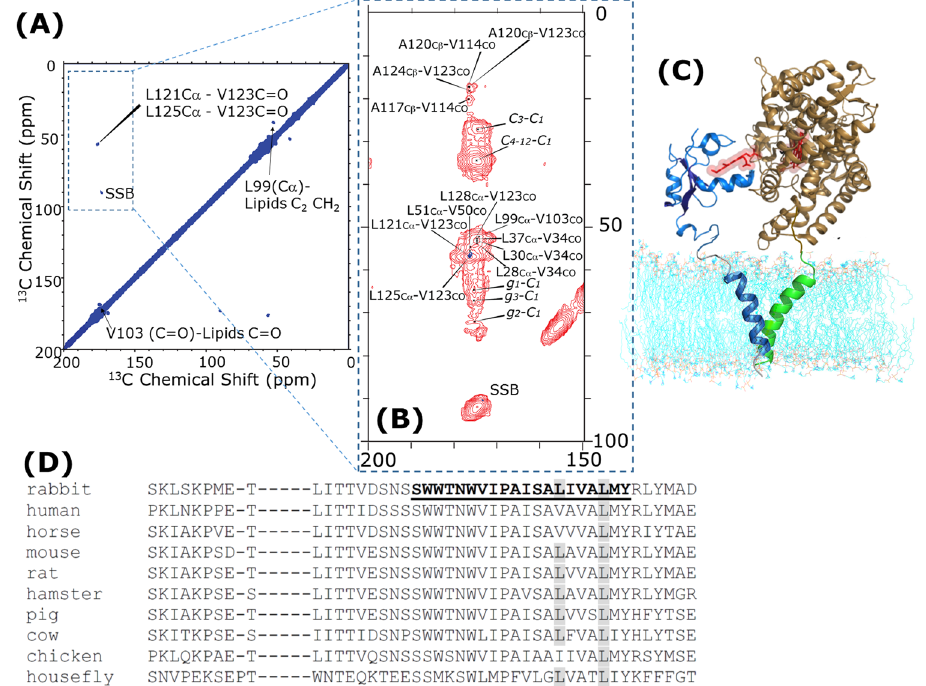
Figure 4. DNP sensitivity-enhanced two-dimensional REDOR-filtered 13 C- 13 C chemical shift correlation spectrum of selectively 13 C-labeled cytochrome b 5 -U- 15 N-labeled cytochrome P450 complex embedded in DMPC MLVs with 10 mM AMUPol in [D 8 ]glycerol/D 2 O/H 2 O (60/30/10 volume ratio). (A) Natural abundance 13 C magnetizations of U- 15 N cytochrome P450 selected by 15 N- 13 C REDOR scheme 104 , which are encoded during the t 1 evolution, and subsequently correlated to the neighboring 13 C nuclei of selectively 13 C-labeled cytochrome b 5 . The spectrum was obtained with microwave irradiation at 12.5 kHz MAS, 99.5 K sample temperature. A 3 s PDSD mixing time, 256 t 1 increments, 128 scans, 32 dummy scans, and 4.68 s recycle delay were used. Total experimental time was 70 hours. The REDOR-filter of 2.56 ms, the CP contact time of 1.5 ms, and 100 kHz SPINAL64 pulse sequence to decouple protons during the signal acquisition of 13 ms. Covariance NMR was used for the two-dimensional spectrum processing. ( B ) DNP sensitivity-enhanced two dimensional 13 C- 13 C PDSD chemical shift correlation spectra of selectively 13 C-labeled cytochrome b 5 embedded in DMPC MLVs from Fig. 2(A) (in red) is overlaid on REDOR-filtered 13 C- 13 C chemical shift correlation spectrum of selectively 13 C-labeled cytochrome b 5 -U- 15 N-labeled cytochrome P450 complex from Fig. 4(A) (in dark blue). (C ) A structural model of full-length cytochrome P450-cytochrome b 5 complex is constructed based on transmembrane-transmembrane interactions obtained from DNP-MAS-ssNMR spectroscopy in this study, and our structural model of soluble domain interactions in a previous study 15 . High-resolution NMR structure of full-length rabbit cytochrome b 5 in lipid bilayers, and the transmembrane α -helix of cytochrome P450 were attained from our previous studies. (D ) The sequence alignments of cytochrome b 5 from various eukaryotes suggest the presence of a highly conserved LxxxL motif between L121 and L125. The underlined area is the hydrophobic α -helix transmembrane domain of cytochrome b 5 . Conserved Leucine residues in the position of 121 and 125 are shaded in black. The amino acid sequences and accession numbers obtained from the NCBI nucleotide data bank are rabbit (P00169), human (P00167), horse (P00170), mouse (P56395), rat (P00173), hamster (P70116), pig (P00172), cow (P00171), chicken (P00174), and housefly